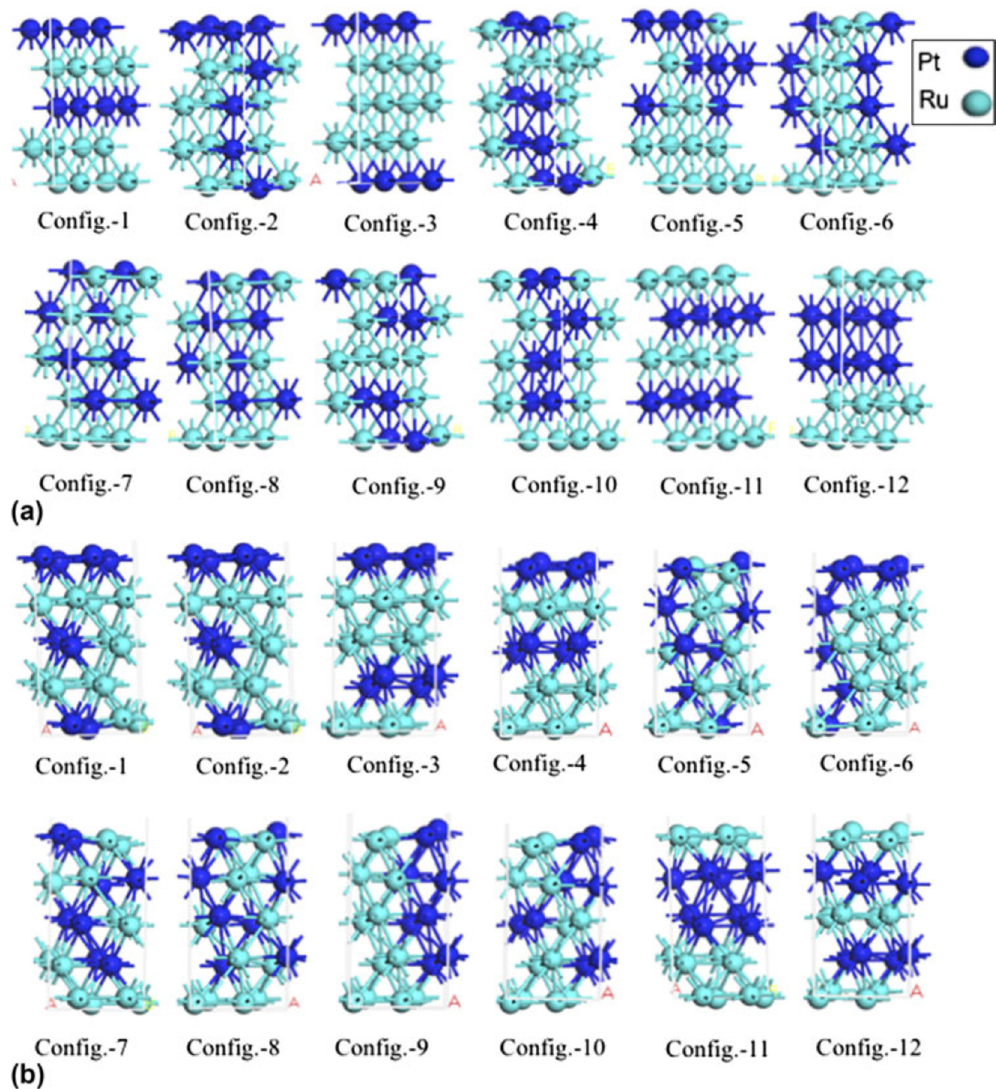
Figure 6: ( a ) Slab con fi gurations of Pt 2 Ru 3 alloy built on platinum - based face - centred cubic structures for diverse conformities of platinum and ruthenium atoms. ( b ) Slab con fi gurations of Pt 2 Ru 3 alloy built on ruthenium - based hexagonal close - packed structures for various conformations of platinum and ruthenium atoms [ 106 ]